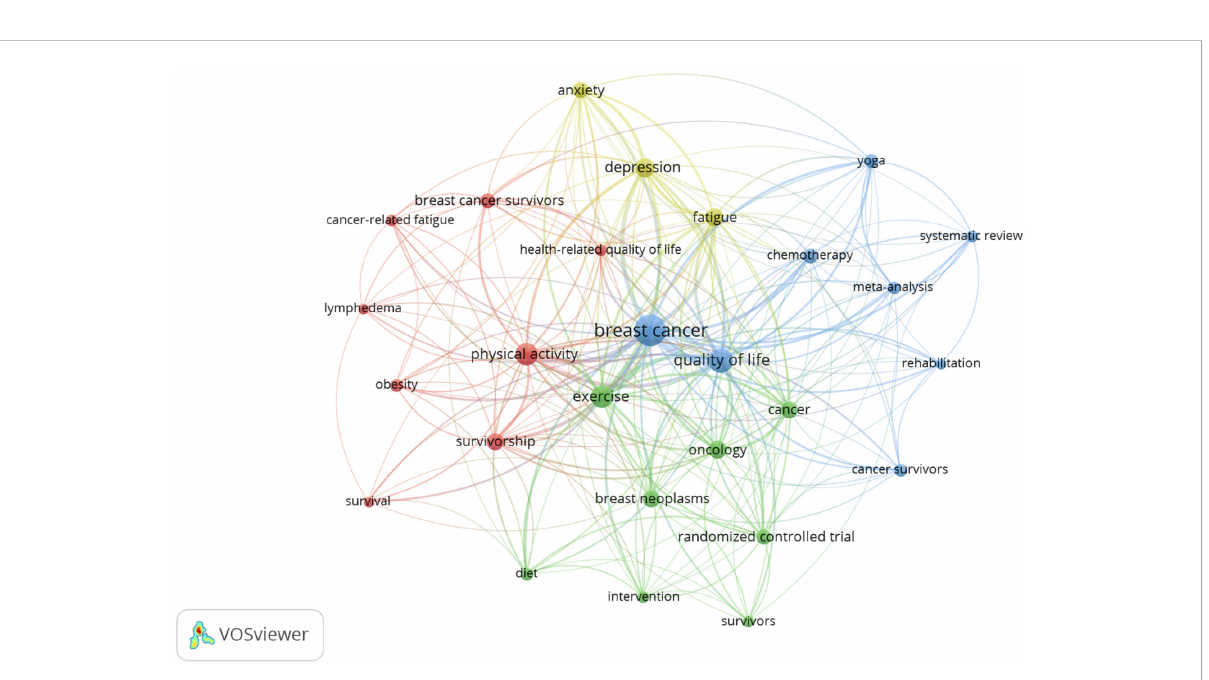
FIGURE 7 Graph with the most used keywords by